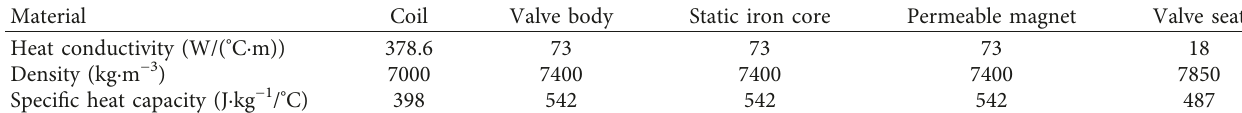
Table 3: Material parameters of